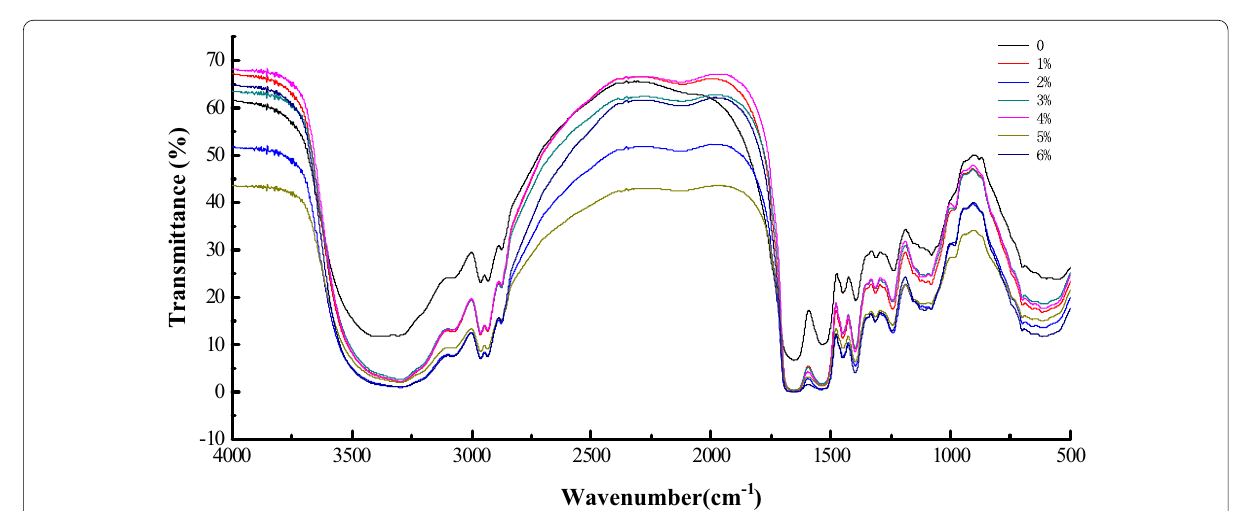
Fig. 3 Fourier transform infrared spectroscopy of SPH at 0–6% DH, respectively